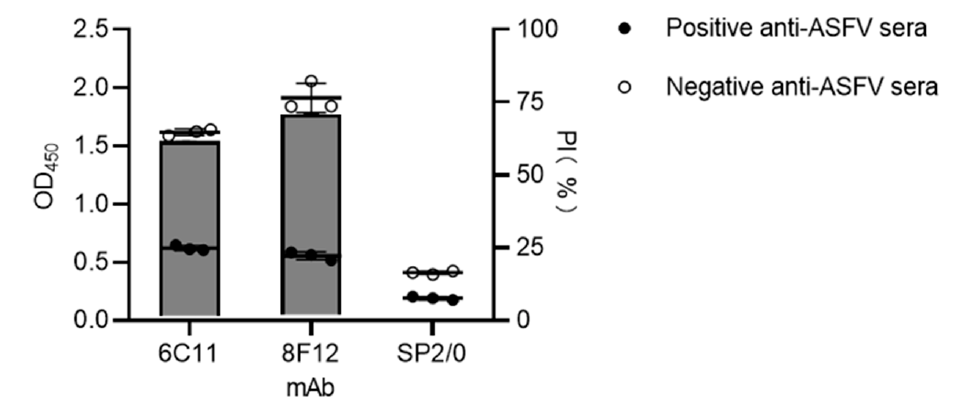
Figure 3. Blocking/competitive ELISA detection of positive anti-ASFV sera against mAbs 6C11 and 8F12. Negative anti-ASFV sera was set to determine negative sample OD 450 value of blocking/competitive ELISA. SP2/0 cell supernatants were used as negative control. Data are presented as mean ± SD.